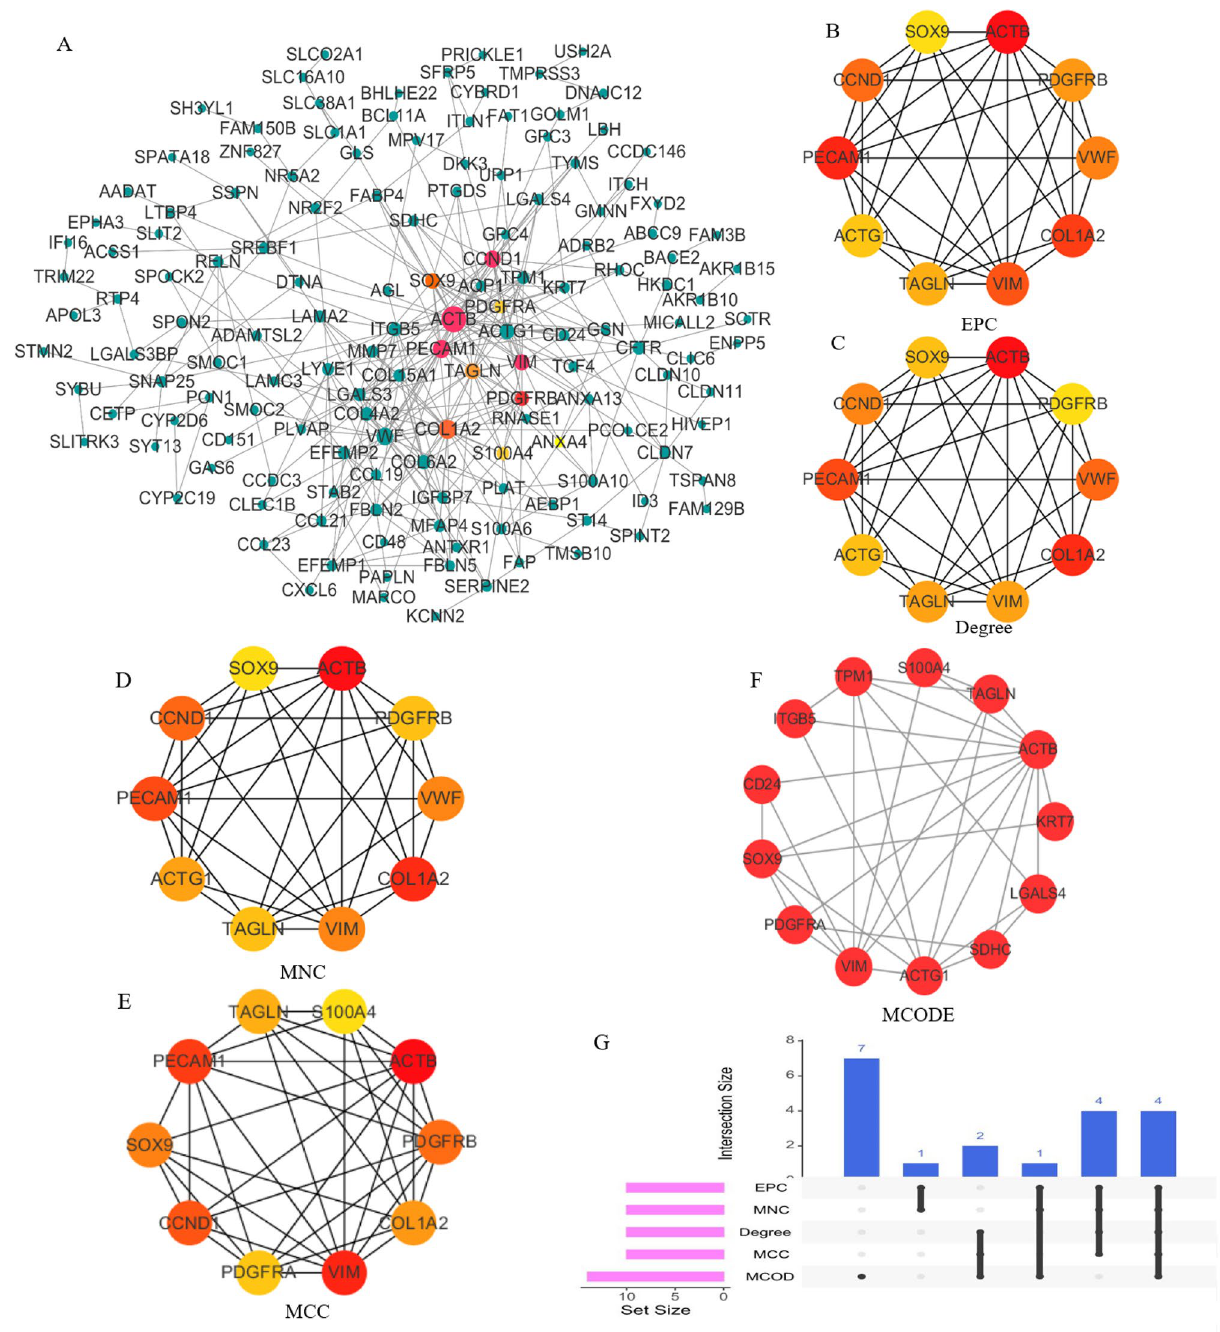
Figure 4. Construction of PPI network and identification of hub DEGs. ( A ) The PPI network of differentially co-expressed cirrhosis-related genes. ( B ) The top 10 hub DEGS with the highest connectivity extracted by EPC (color depth for ranking of hub DEGs). ( C ) Top 10 hub DEGs with the highest connectivity identified by Degree (color depth for ranking of hub DEGs). ( D ) Top 10 hub DEGs with the highest connectivity identified by MNC (color depth for ranking of hub DEGs). ( E ) Top 10 hub DEGs with the highest connectivity identified by MCC (color depth for ranking of hub DEGs). ( F ) Top 10 hub DEGs with the highest connectivity identified by MCODE (color depth for ranking of hub DEGs). ( G ) The UpSet diagram shows the intersection of the top 10 HUB genes obtained by the above five methods (Pink bar represents the five methods, and blue bar represents the intersecting